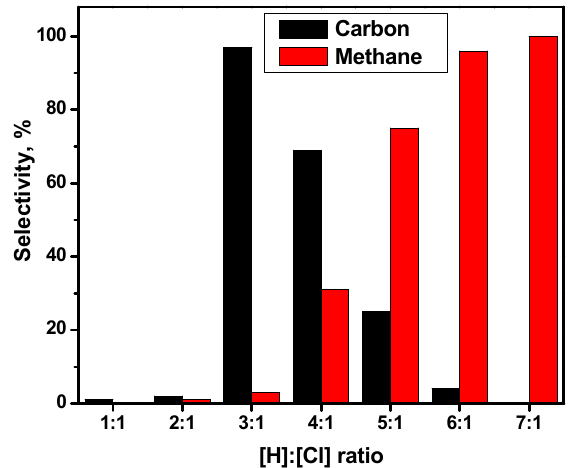
Figure 6. The dependence of the reaction selectivity upon the molar ratio [H]:[Cl] ( α ) of the reaction mixture [CHCl 3 + H 2 ] over Ni/Al 2 O 3 catalyst at 500 °C.